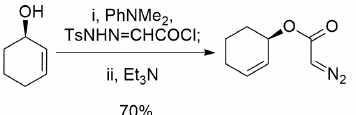
Figure 38 - Example of the House method modification proposed by Corey and Myers.